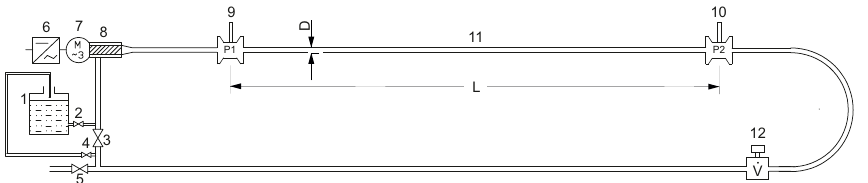
Figure 1. Scheme of the test stand and general view of the measuring section, where: 1-tank with tested liquid, 2-5-valves, 6-frequency converter, 7-three phase electric motor, 8-screw pump, 9-inlet pressure (P1) sensor with transducer, 10-outlet pressure (P2) sensor with transducer, 11-measurement section with D diameter and L lenght, 12-volumetric flow rate